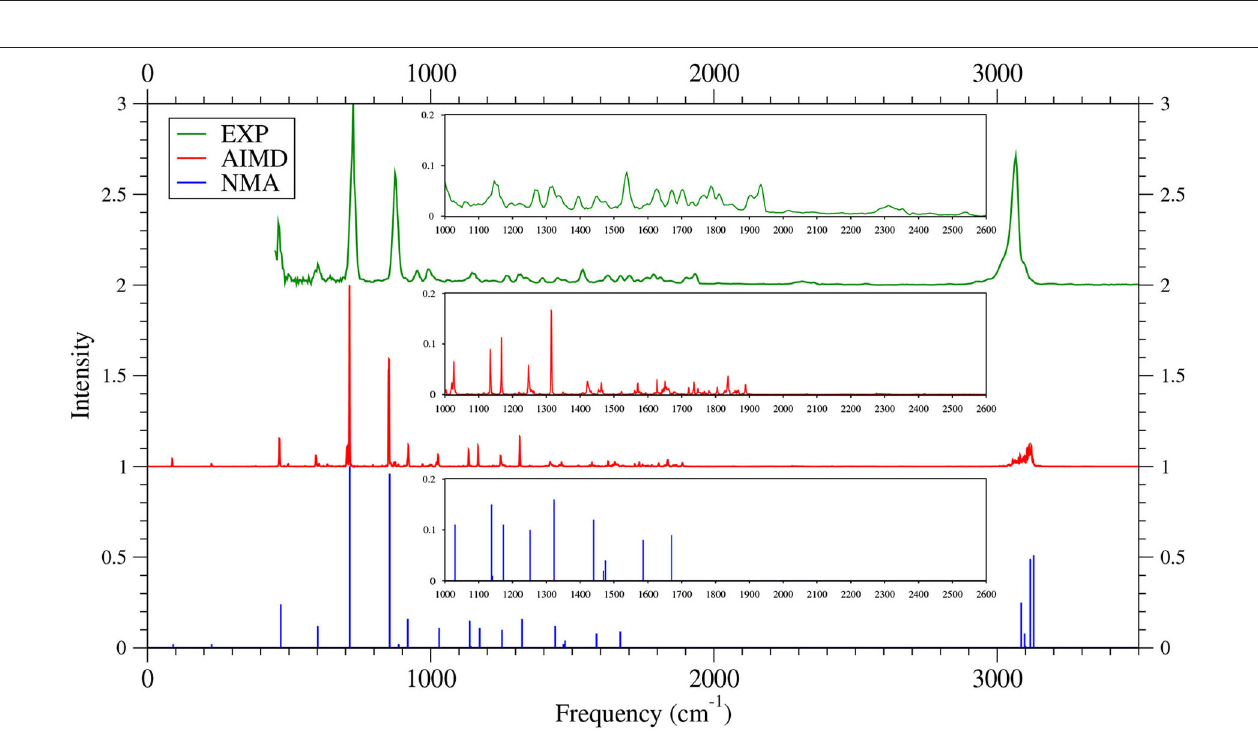
FIGURE 7 | IR spectra of 3-acene, obtained with the TAO-AIMD simulations at 300 K and GS-NMA, calculated by TAO-LDA. Experimental (EXP) data NIST mass spectrometry data center (2020) are included for comparison. The IR spectra are normalized to have a maximum intensity of one and, for clarity, are vertically offset from each other by the same value. Subfigures show the IR spectra in the 1,000–2,600 cm − 1 range.